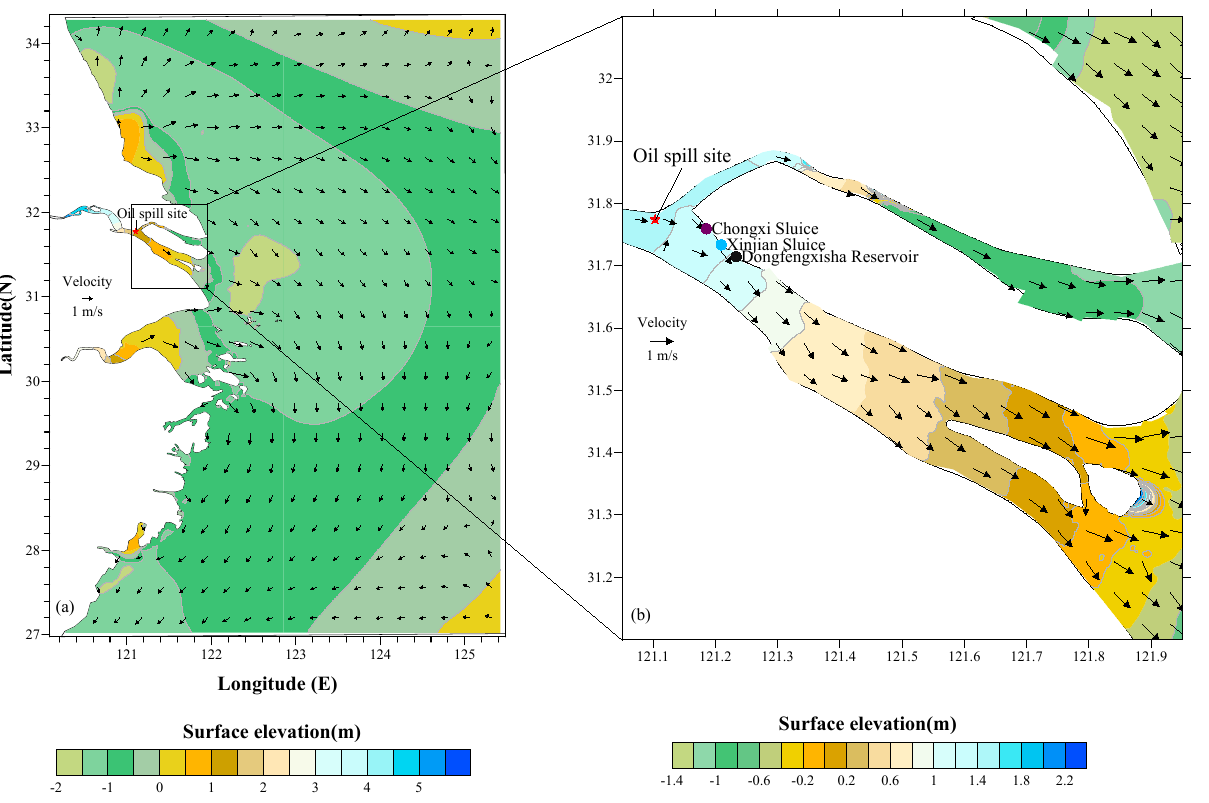
Figure 4. ( a ) The ebb current field; ( b ) the oil spill site and 3 main sensitive areas. Table 2. Simulation